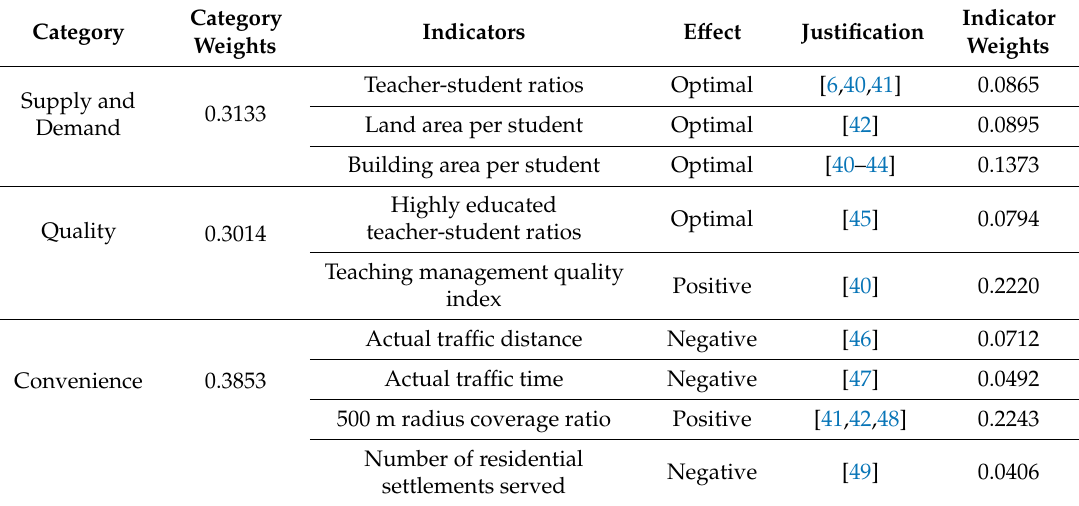
Table 1. Primary indicators and weight value for primary schools in major categories.